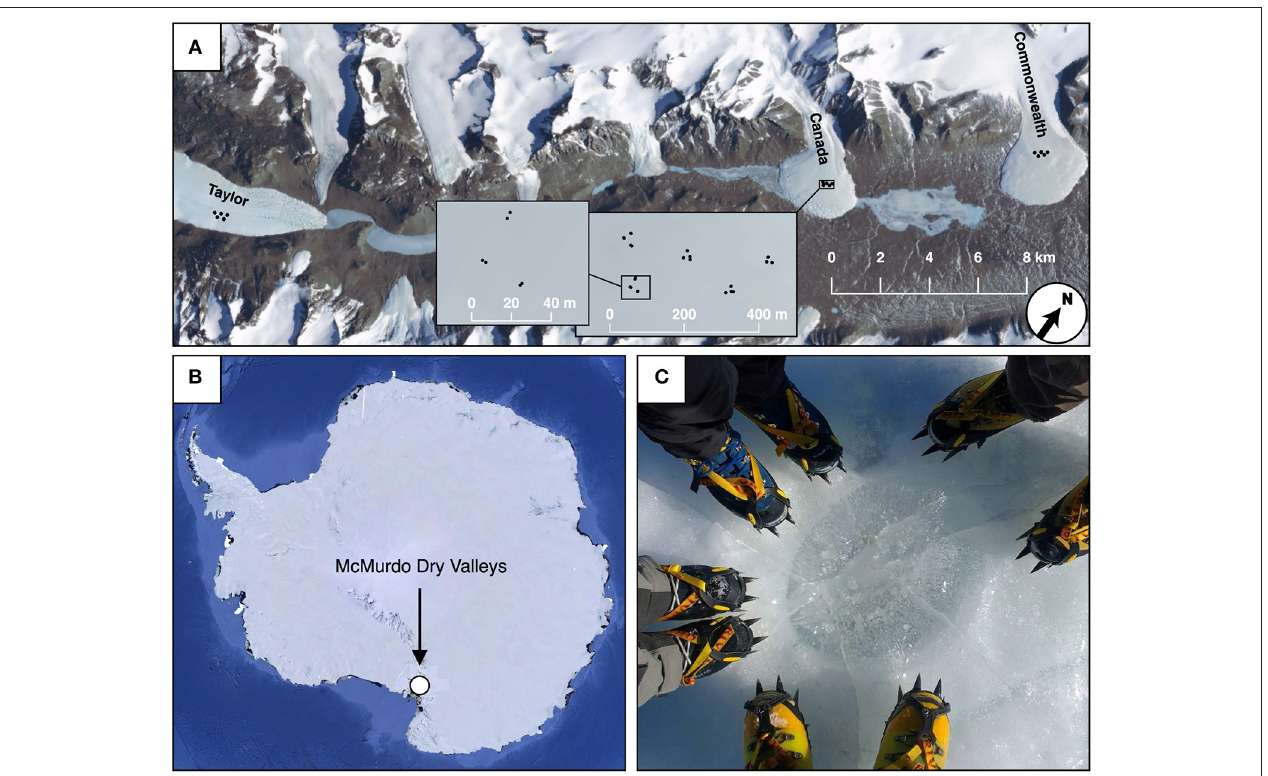
FIGURE 1 | Map and sampling design for Taylor Valley cryoconite holes. Samples on Taylor, Canada, and Commonwealth glacier (A) used spatially nested sampling designs, consisting of pairs of samples roughly 5 meters apart (varying depending on cryoconite availability), in triangles with sides measuring 25 meters ( A , inset). Five of these triangles were nested within a triangular grid, with 150m between each triangle ( A , inset). The position of the McMurdo Dry valleys (where Taylor Valley is) within Antarctica is shown (B) , as well as a photograph of a cryoconite hole on Canada Glacier with the authors’ boots for scale (C)